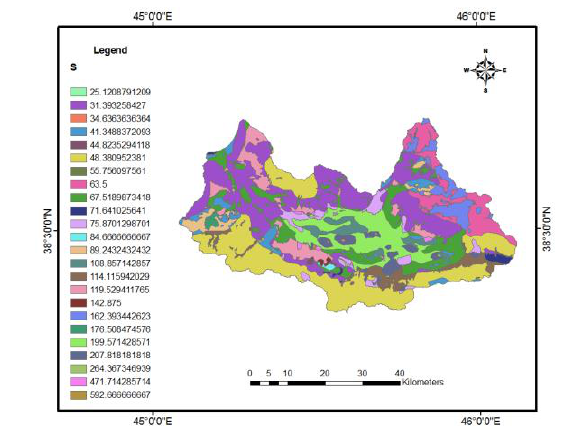
Figure 6. Soil retention coefficient map of Zilberchai Basin